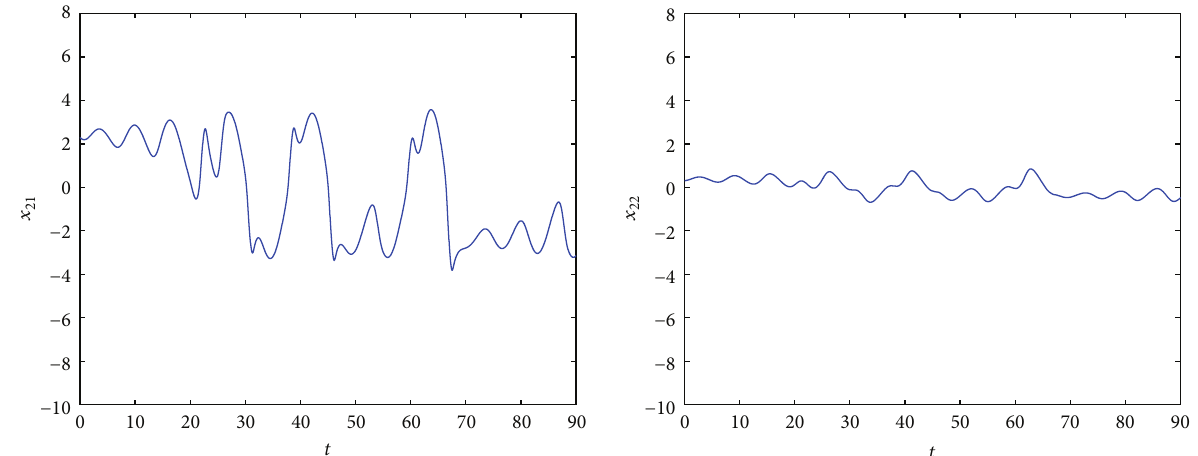
Figure 3: The state trajectories 𝑥 21 and 𝑥 22 of the second